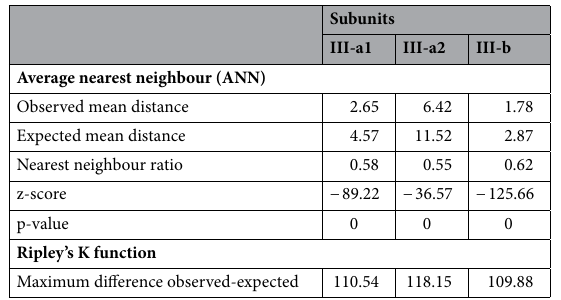
Table 7. Statistical results obtained from the application of ANN and Ripley’s K